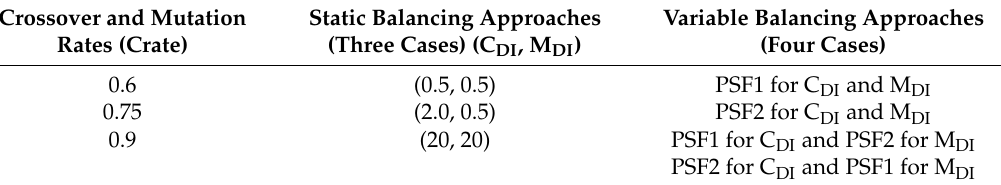
Table 4. Parameter values of the